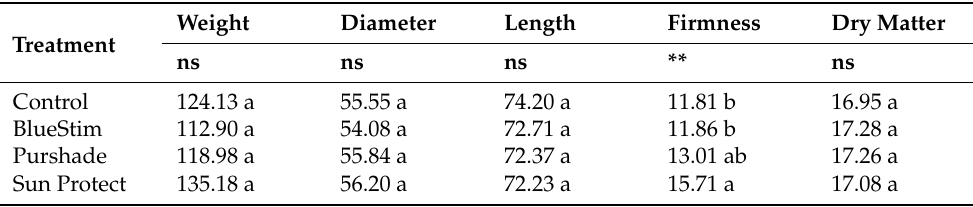
Table 2. Alleviating products’ application effect on kiwifruit mean weight (g), diameter (mm), length (mm), firmness (N), and dry matter percentage (%) after storage at 0.5 ◦ C for 107 days.